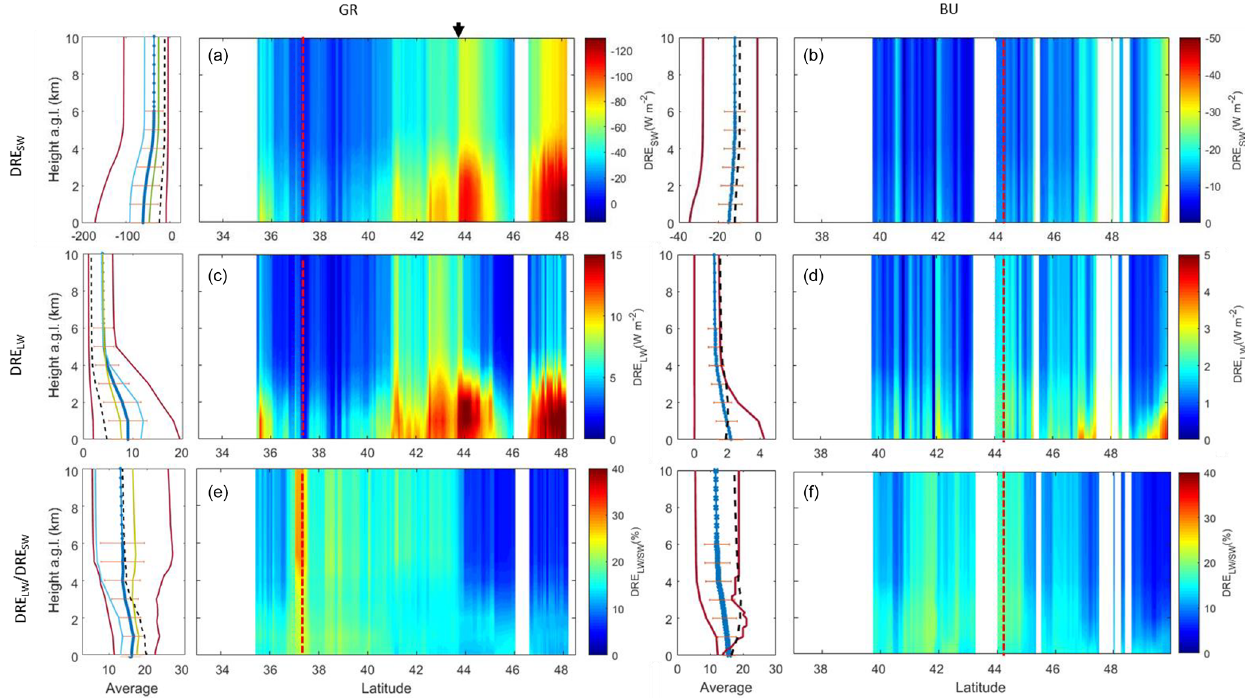
Figure 7. Averaged profiles (blue lines) showing their standard deviation (orange error bars), and curtain plots of the DRE SW (a, b) , DRE LW (c, d) and DRE SW / DRE LW (e, f) profiles obtained along the CALIPSO track for GR (a, c, e) and BU (b, d, f) . Note the dif- ferent scales. The red solid lines show the profiles corresponding to minimum and maximum, AOD and the dashed black lines represents the profiles above the ground-based sites. For GR, the green and light blue lines show the averaged profiles for land and ocean, respectively. The dashed red vertical lines represent the location of the EARLINET stations. The black arrow above panel (a) indicates the latitude where the surface shifts from land to ocean.